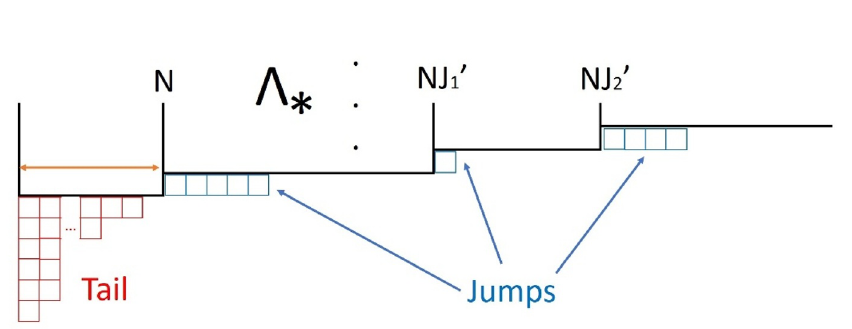
Figure 1 . Tail and jumps that forms ~(cid:21) on top of limit shape ~ (cid:3) (cid:3)